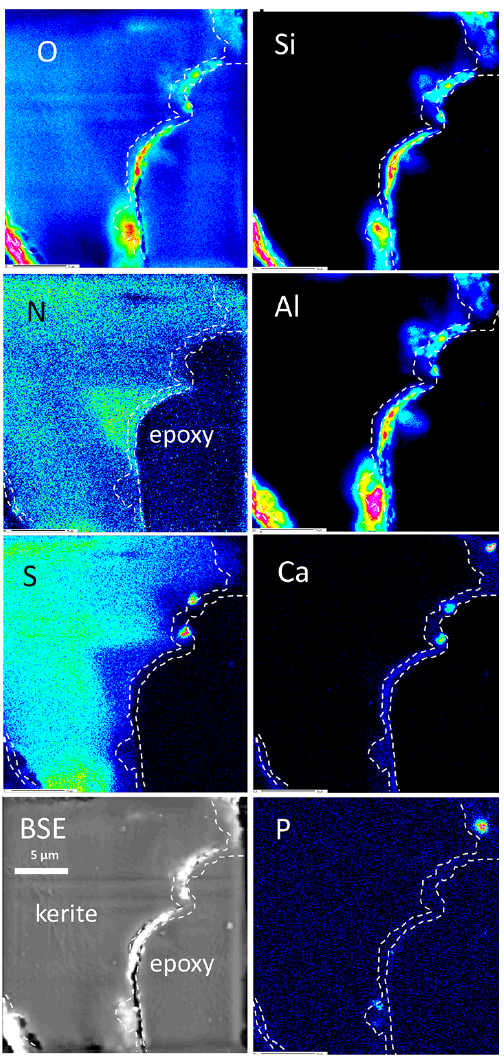
Figure 11. Element distribution (EMPA) of the rim of flaky kerite. The rim is outlined as seen in the Ca image. Si, Al, and O are concentrated in a discontinuous rim, indicating Al silicates. Ca is concentrated in spots, together with P and S, indicating Ca sulfates and Ca phosphates but also in a continuous rim with concentrations slightly above the background. Sulfur – except for the enrichment in spots – is absent in this area and also less concentrated near to the rim. N distribution is heterogeneous, but as in Fig. 9 it can extend up to the outer rim. Areas rich in N are poor in